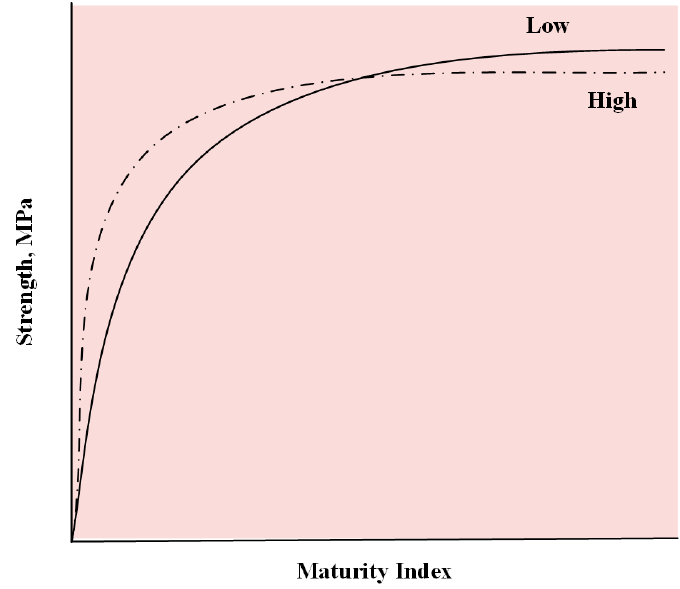
Figure 1. Crossover effect (COE) with maturity and strength at low and high